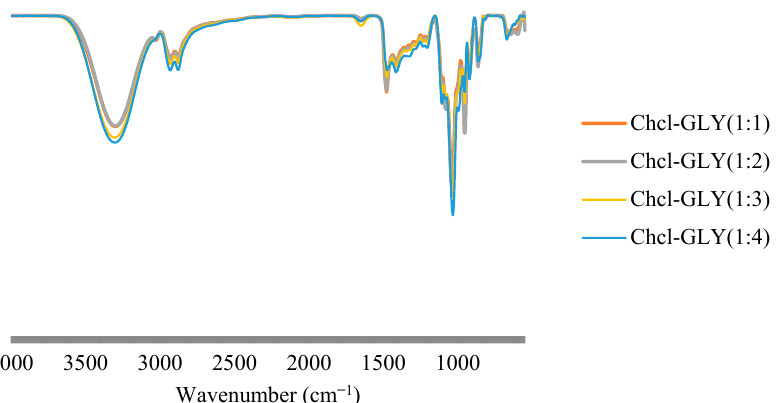
Figure 6. Comparison of ChCl-PEG (1:4) FTIR graph with its respective pure components.